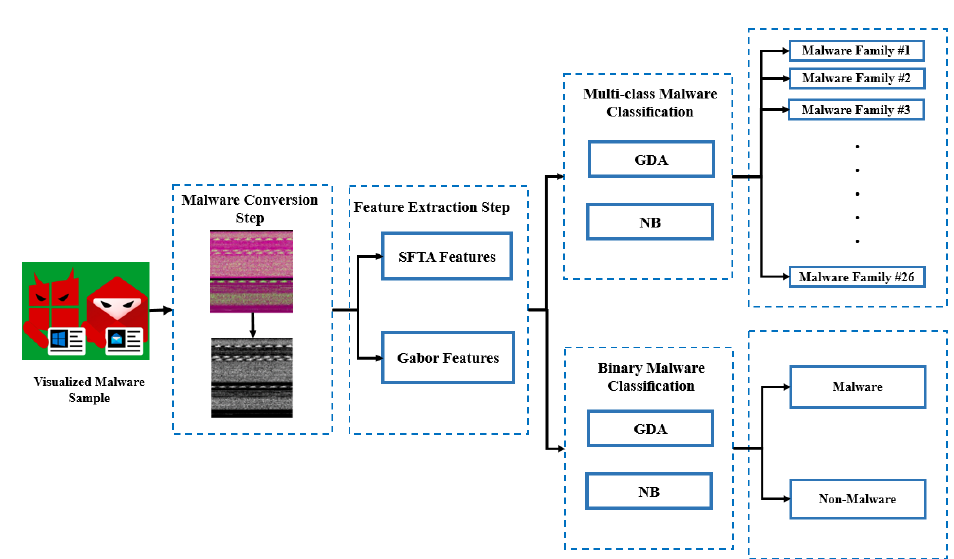
Figure 4. Proposed method Flowchart.